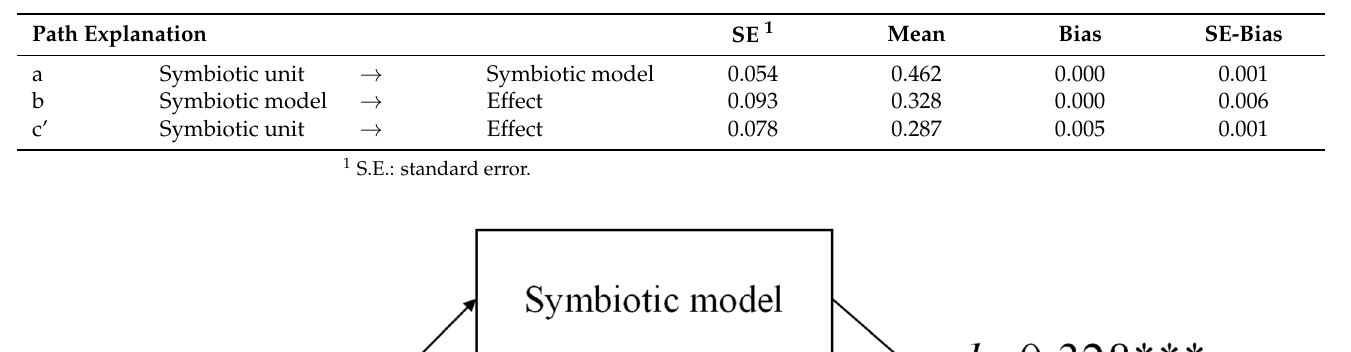
Table 10. Results of symbiotic unit, model and effect mediation test. Effect